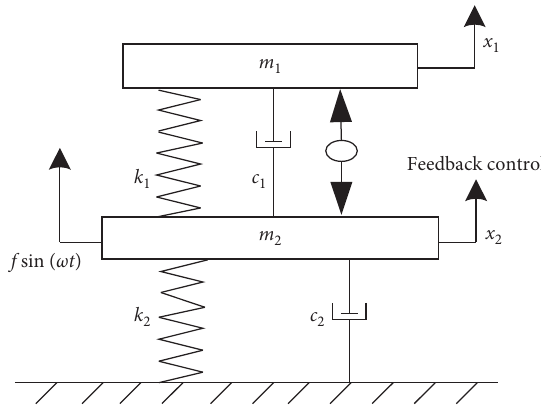
Figure 1: Mechanical model of the coupled